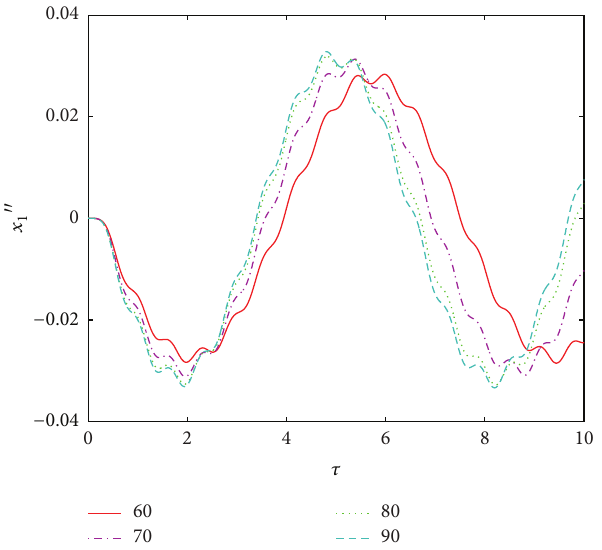
Figure 3: The effect of the peak pulse acceleration on dimensionless acceleration response of critical components, where 𝜏 0 = 0.5 , 𝜑 0 = = 10 , and 𝜆 = 0.01 . 60 ∘ , 𝜆 1 2